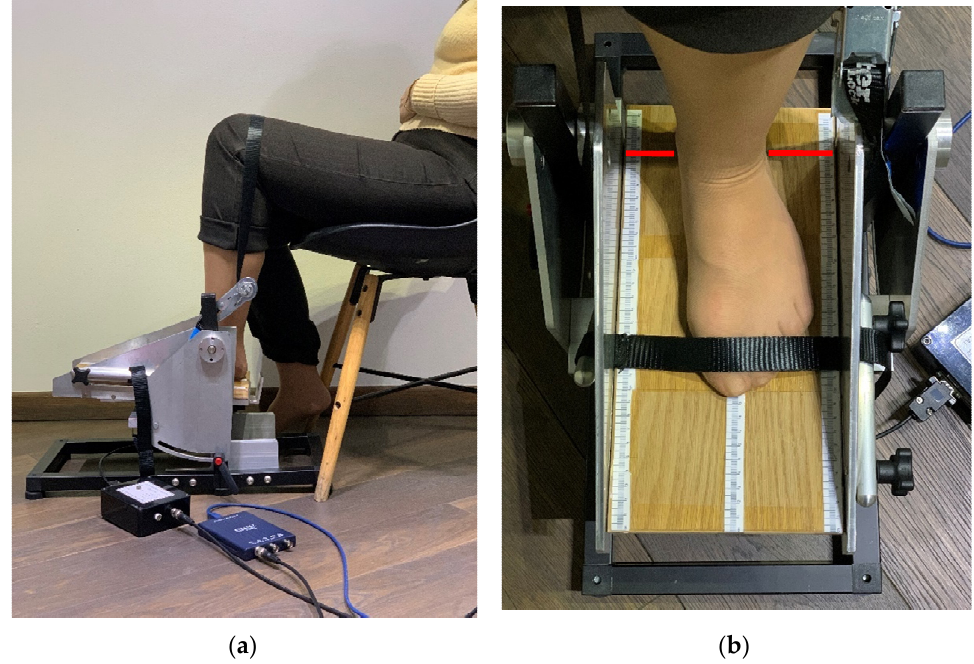
Figure 5. The participant’s position sat on a chair with trunk on the chair backrest: ( a ) fixation of strap just above the knee level, with tibia long axis perpendicular to the ground parallel and knee joint flexed at 90–110°; ( b ) strap fixation on the dorsum of the foot just above the MPJ joints, for a rigid fixation of the foot position on the dynamometer plate. The ankle malleoli axis is right above the pivotal line marked on the apparatus plate with a red line.